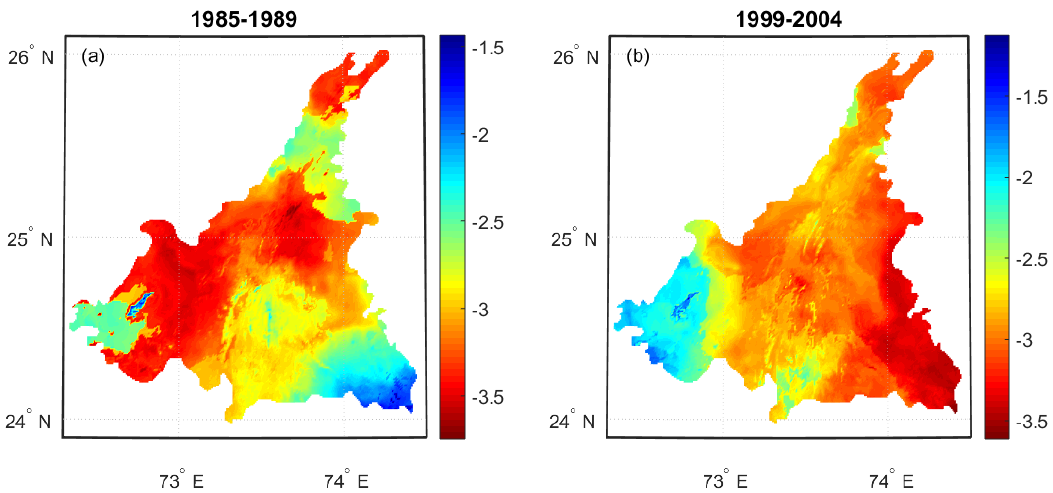
Figure 6. Various events of major droughts ( a , b ) of at least two years of duration observed in the Araveli study area from 1950 to 2016. Each plot shows the averaged value of the self-calibrating Palmer Drought Severity Index (scPDSI) over the drought period. The scalebar represents corresponding scPDSI units.